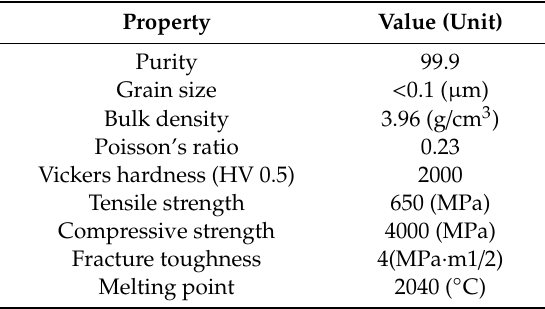
Figure 2. ( a ) Measuring the workpiece flatness by using dial gauge and ( b ) RUM tool used for pocketing. Table 3. Mechanical and thermal properties of Al 2 O 3